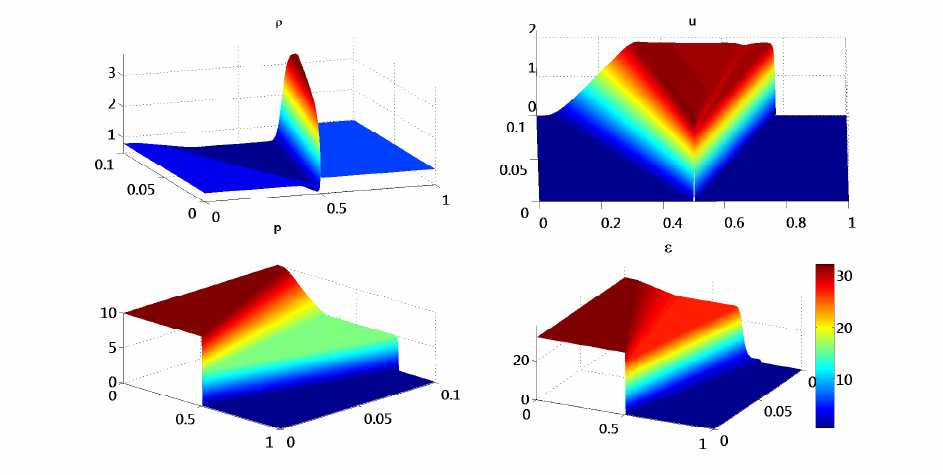
Figure 4. Test 2 (the stiffened gas): the space–time graphs.